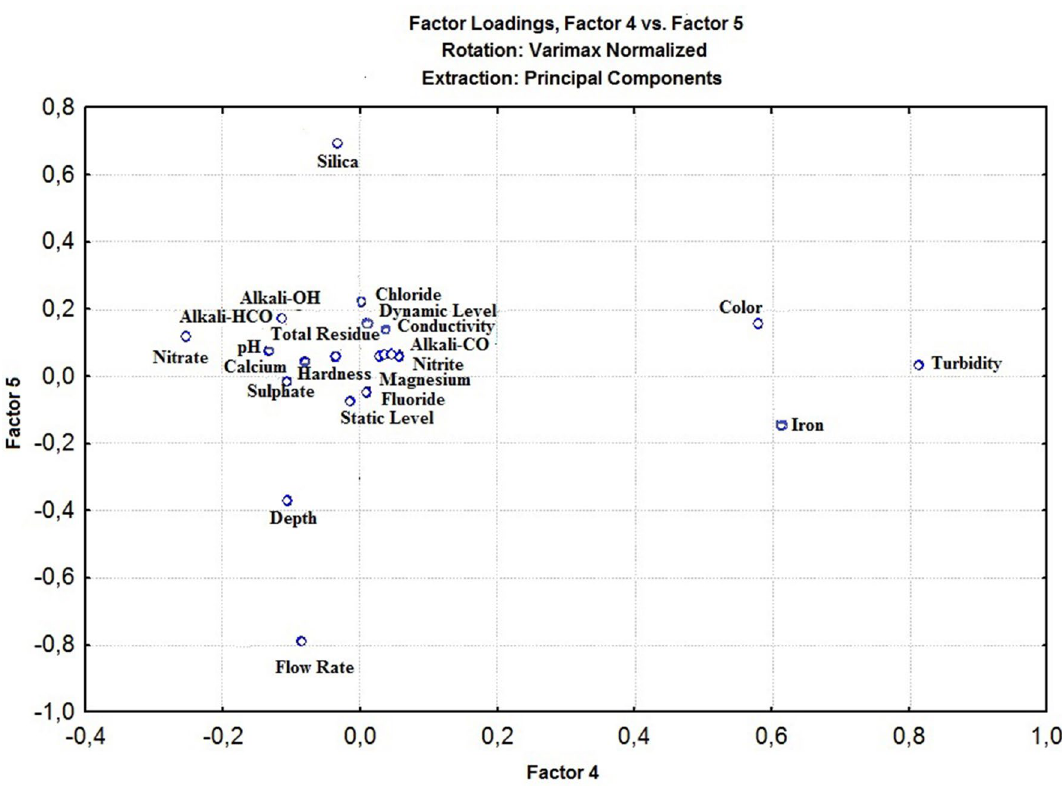
Figure 5. Graphical representation of factors F4 x F5 (Normalized Varimax Rotation), using Statistica, version 7.0 115 (Factor 2) emerged three (3) hydraulic variables with the greatest factorial loads: the dynamic level (− 0.922), static level (− 0.862), and depth (− 0.810). The total of significant parameters, so far, is ten (10). In Fig. 4 (Factor 3 × Factor 4), the (Factor 3) explains 9.56% of the total variability of the data, and (Factor 4) explains 7.67%, shown on Table 7. From (Factor 3), the parameter fluoride has great significance (0.702), and from (Factor 4), turbidity has factor load (0.814), and iron (0.613). Turbidity was discharged because during a normal regime of groundwater exploitation this parameter is no longer significant in the water well. Thus, two (2) significant water quality parameters were identified, totaling twelve (12) significant parameters. In Fig. 5 (Factor 4 × Factor 5), the (Factor 4) explains 7.67% of the total variability of the data, and (Factor 5) explains 6.01%, as shown on Table 7. From (Factor 5), the parameter flow rate with factor load (− 0.792) is the most significant. Consequently, the number of factors to be involved in the hierarchical cluster analysis is thir- teen (13), with nine (9) related to water quality, and four (4) are hydraulic parameters. However, the hydraulic parameters, not related to water quality, will not be considered to compose the GWQI. Figure 6 presents the dendrogram from the hierarchical cluster analysis (HCA). The dendrogram shows the formation of 3 groups of parameters with high internal similarity: “hardness x chloride”, “total residue x conductivity”, and “calcium x magnesium and sulphate”. This work choose only five (5) relevant variables, a total that responds for 63.91% of the total variance, satisfying the recommendation from 118 . The choices were: hardness (instead chloride, as they belongs to the same group); total residue (instead conduc- tivity, as total residue is a chemical parameter); sulphate (instead calcium or magnesium, as both variables are present in hardness). In addition, were considered fluoride and iron, which are independent from each other. Thus, the variables to include in the GWQI to express the state of Bahia groundwater quality are: hardness, total residue, sulphate, fluoride and iron. The next step for the GWQI formulation is, to define the degree of relevance of each parameter, in order to establish the relative weight (w i ), necessary to the GWQI model. The starting point was to examine the commu- nality values calculated after the normalized Varimax rotation, which represent the amount of variance explained by each variable in the factorial solution. The Table 6 presents the communality values (from 1 to 6 factors). The largest communality value in the column (5 factors), is hardness (0.972), providing the greatest relative weight (w i ). The others are: total residue (0.962), sulphate (0.579), fluoride (0.511), and iron (0.444). Then, on Table 7 it is demonstrated the procedure to obtain the weights (w i ), based on the communality values for the five parameters (hardness, total residue, sulphate, fluoride and iron). Using the communality values, and the procedure defined in this work, the relative weight (wi) for each parameter is: hardness (0.28), total residue (0.27), sulphate (0.17), fluoride (0.15), and iron (0.13). The sum of the five weights add to one (1.00).